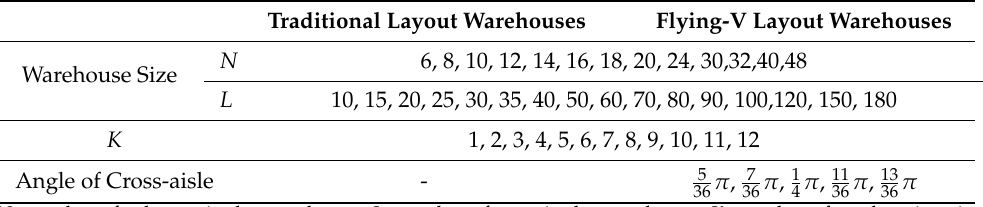
Table 3. Parameter settings of the numerical experiments. Traditional Layout